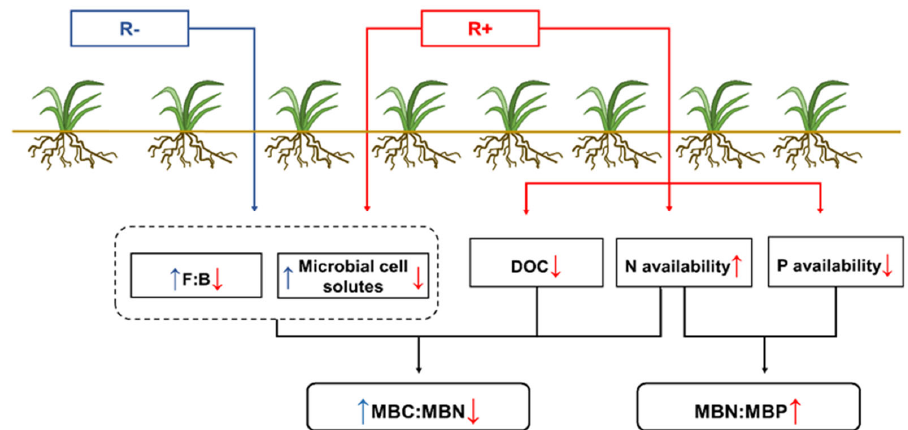
Figure 3. A conceptual framework for the responses of soil microbial biomass stoichiometry to precipitation changes in alpine ecosystems. ↑ , increase; ↓ , decrease; R − , decreased precipitation; R+, increased precipitation; F:B, fungi ‐ to ‐ bacteria ratio; DOC, dissolved organic carbon. The blue lines represent the influencing pathway of decreased precipitation; the red lines represent the influencing pathway of increased precipitation.